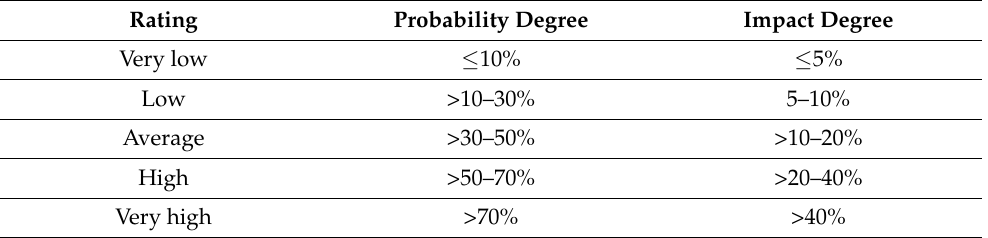
Table 6. Survey of experts to assess the impact of risk factors and their